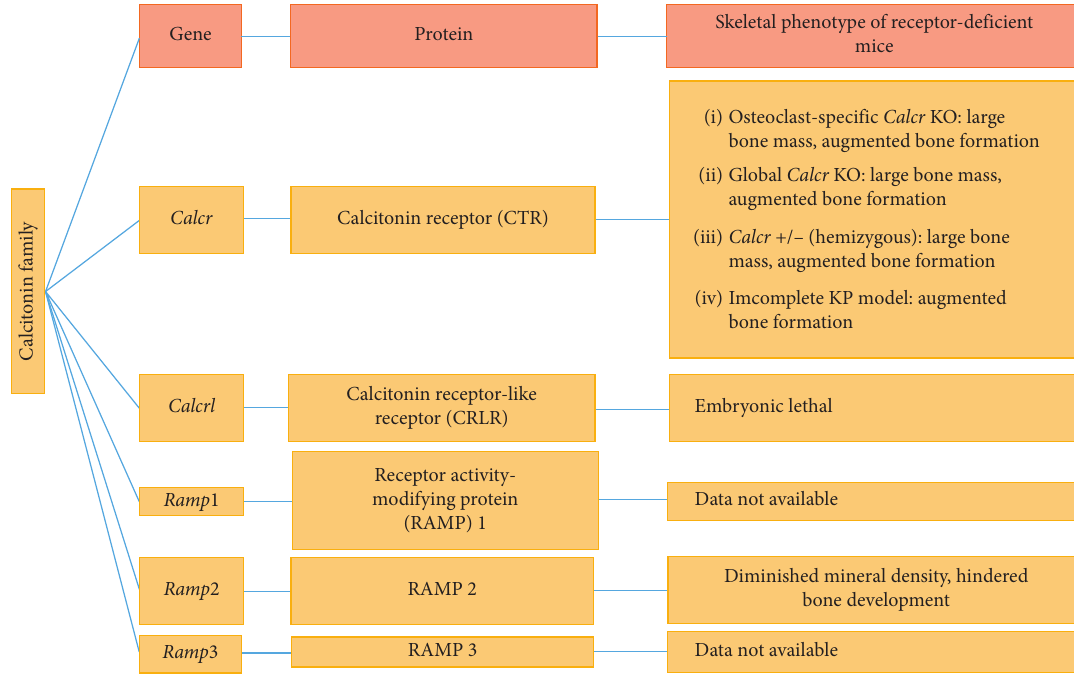
Figure 3: Characteristic properties of the skeletal phenotype of knockout